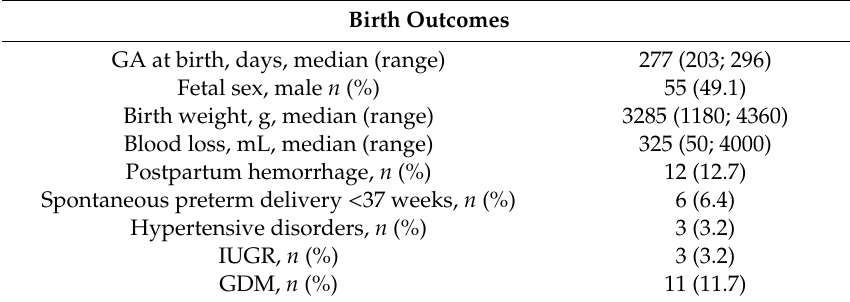
Table 3. Pregnancy and birth outcomes of the study